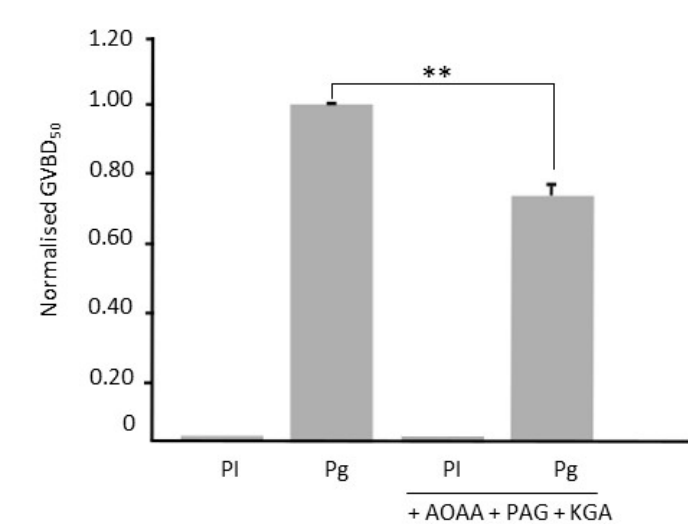
Figure 2. Inhibitors of H 2 S-releasing enzymes accelerate meiosis resumption. ( A ) Western blot detection of endogenous enzymes of the H 2 S metabolism, CBS, CSE, and MPST, in untreated oocytes (PI) and oocytes treated by progesterone (4 µ g / mL) (MII). Total phosphorylated and unphosphorylated forms of Erk2 serves as loading controls. ( B ) Oocytes were pre-incubated or not with a cocktail of H 2 S-releasing enzymes inhibitors AOAA (aminooxyacetic acid-10 mM), PAG ( dl -propargylglycine-10 µ M), and KGA (ketoglutaric acid-10 µ M) before progesterone (4 µ g / mL) stimulation (Pg + AOAA + PAG + KGA) and their white spots were recorded every hour for 24 h. ( C ) GVBD 50 corresponded to the time required to obtain 50% of mature oocytes. GVBD 50 were normalized with the GVBD 50 of the oocytes treated with progesterone only. Twenty oocytes were used in each condition from 3 independent females. Statistical significance was accepted for ** p < 0.01.